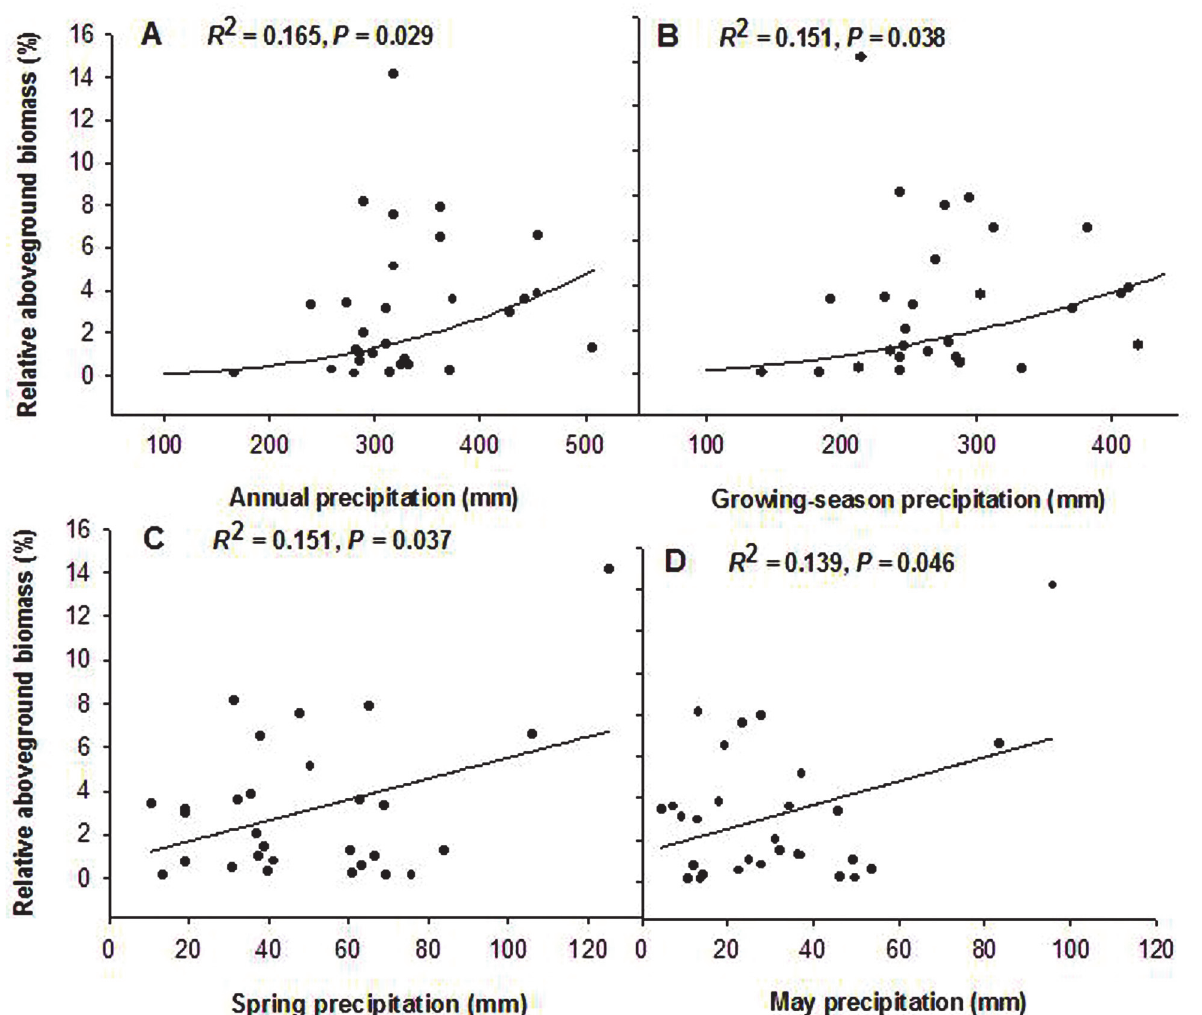
Fig 4. Relationship between relative aboveground biomass of annuals in community and precipitation (1982 – 2012). (A) Annual precipitation; (B) Growing-season precipitation; (C) Spring precipitation; (D) May